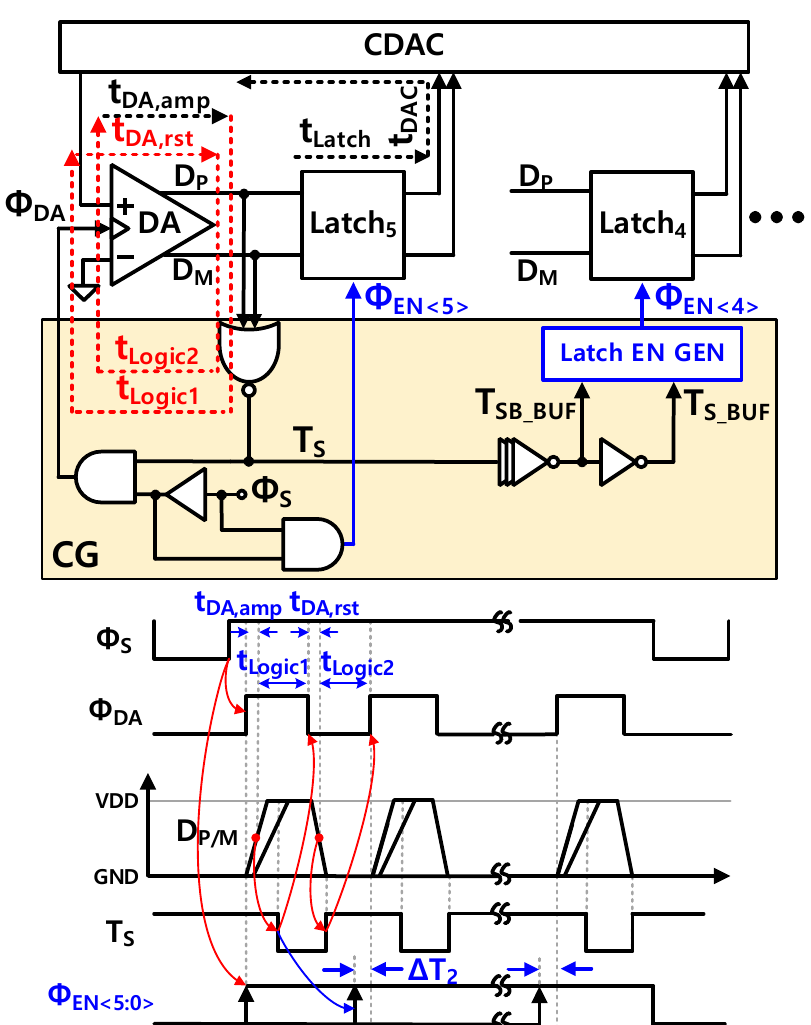
Figure 6. Logic for the CG block in P-LU SAR ADC and the timing diagram.